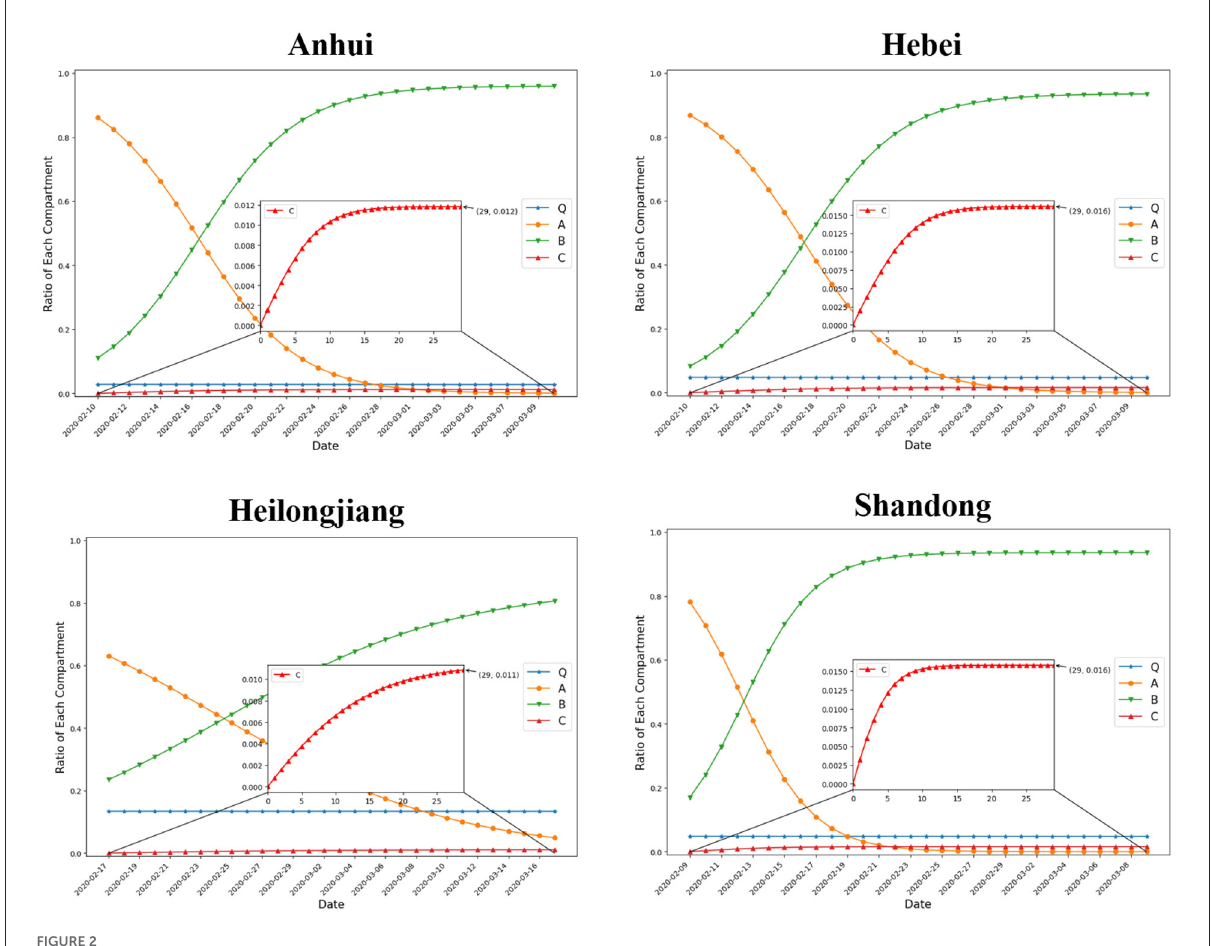
FIGURE2 Dynamics of Q ( t ), A ( t ), B ( t ), C ( t ) over